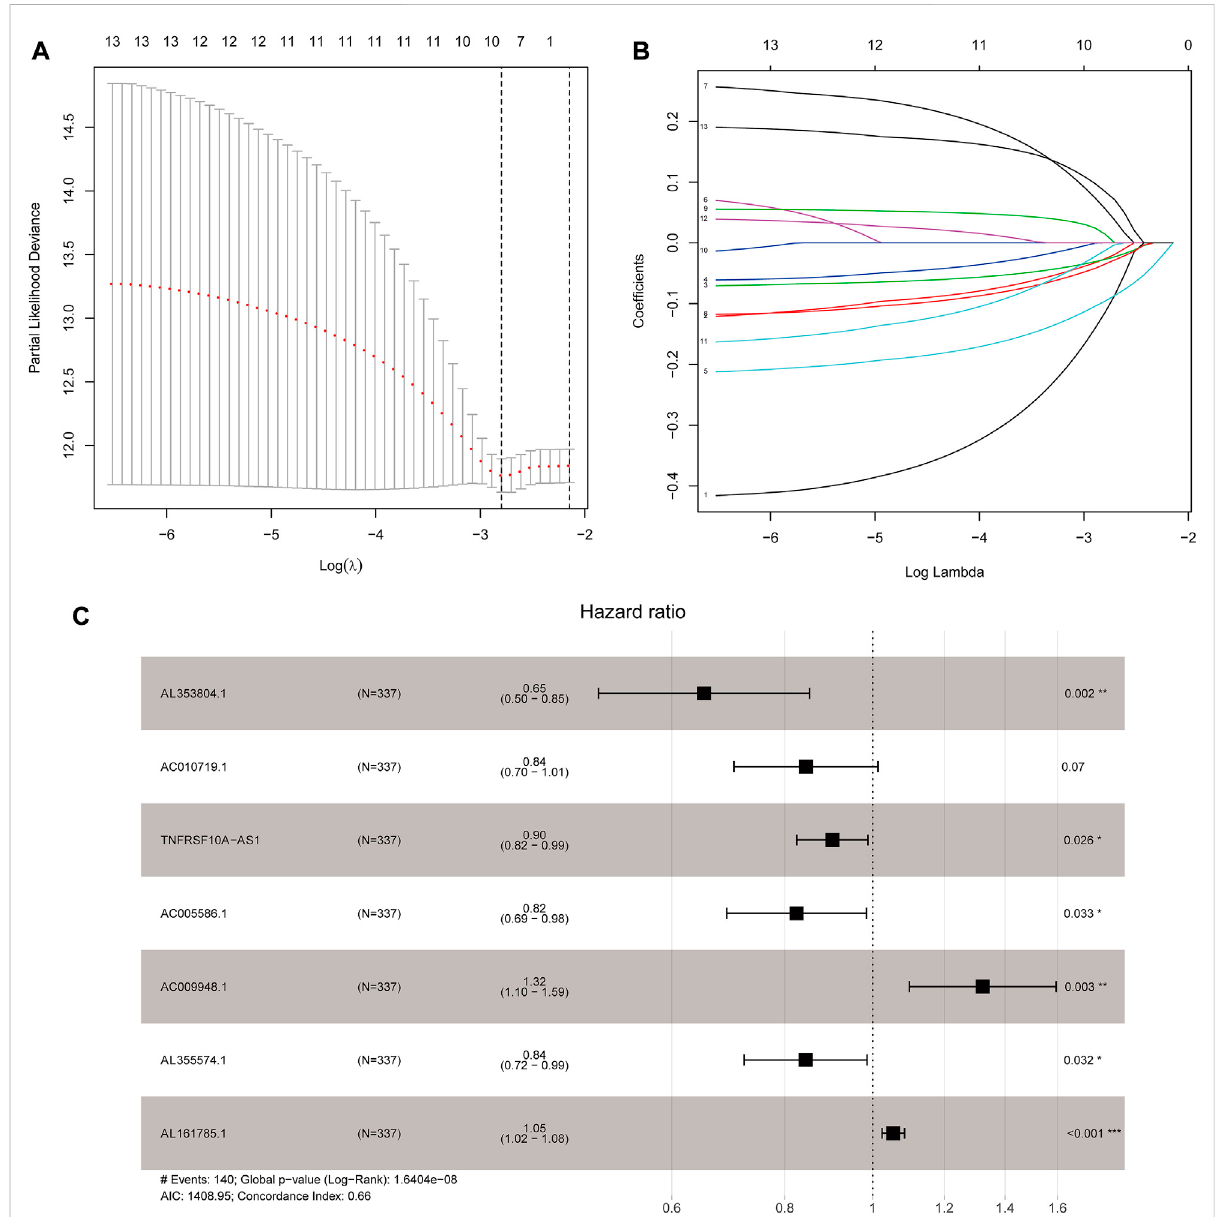
FIGURE 1 Development of the seven glycolysis-related lncRNAs signature. (A) Lasso coef fi cient values of nine glycolysis-related lncRNAs in stomach adenocarcinoma (STAD). The vertical dashed lines are at the optimal log(lambda) value. (B) Variables going to zero as we increase the penalty (lambda) in the objective function of the Lasso. (C) Results of the multivariate Cox proportional hazard model based on the nine variables; seven lncRNAs were screened to construct the